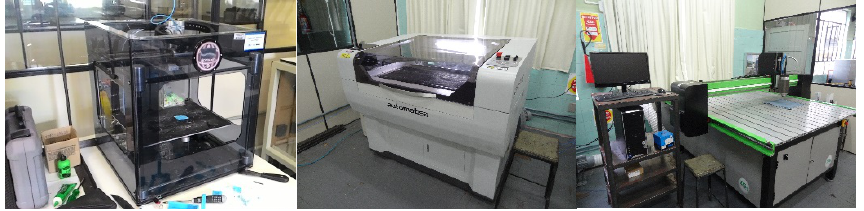
Fig. 3. RP equipment to develop PBL classes (3D Printer, Laser cutting machine and Milling Router).